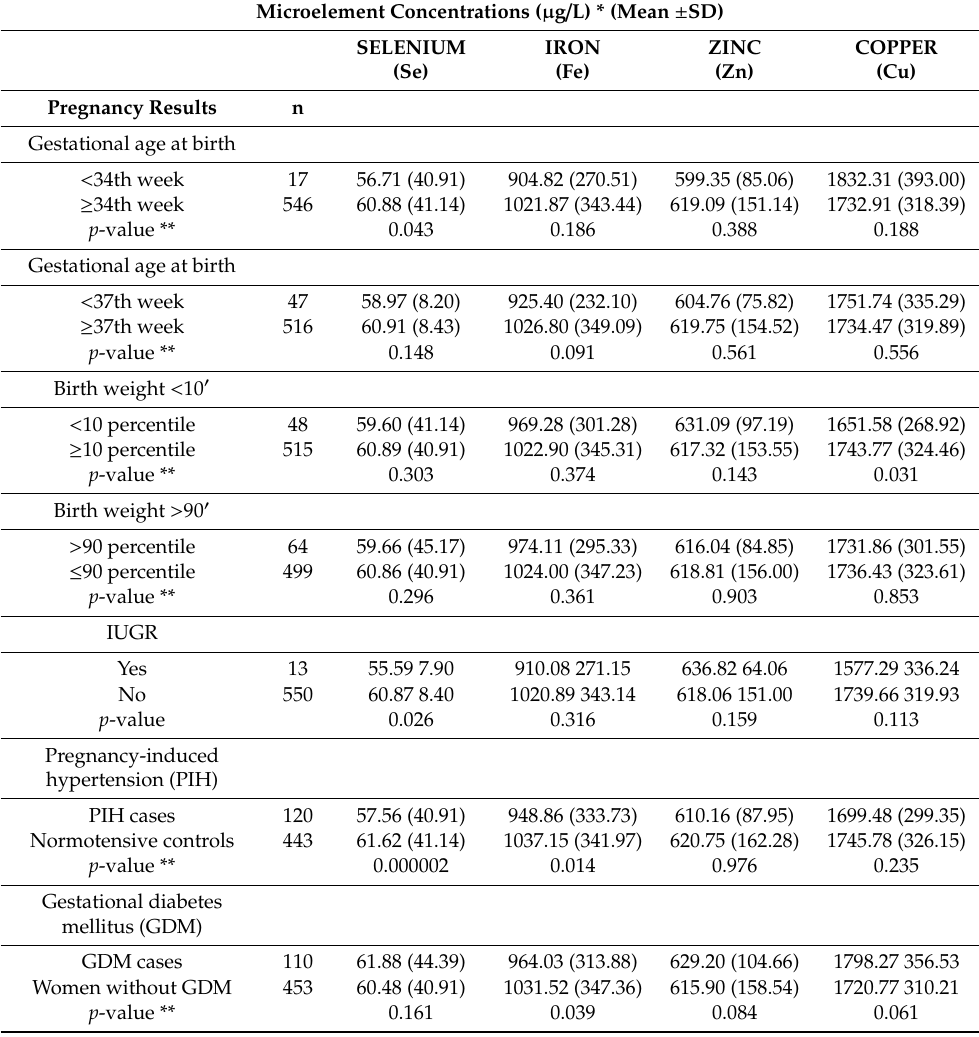
Table 5. The microelement concentrations (in the 10–14th week of pregnancy) and pregnancy